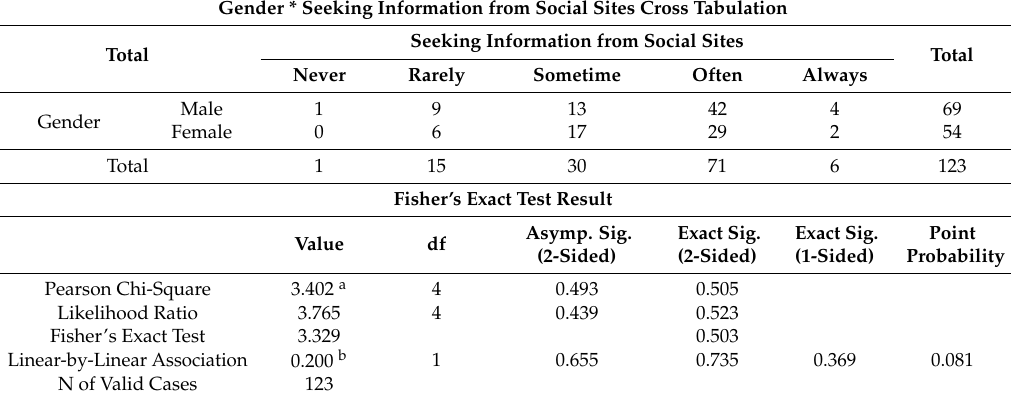
Table 5. Gender and Social Information Seeking Chi-Square